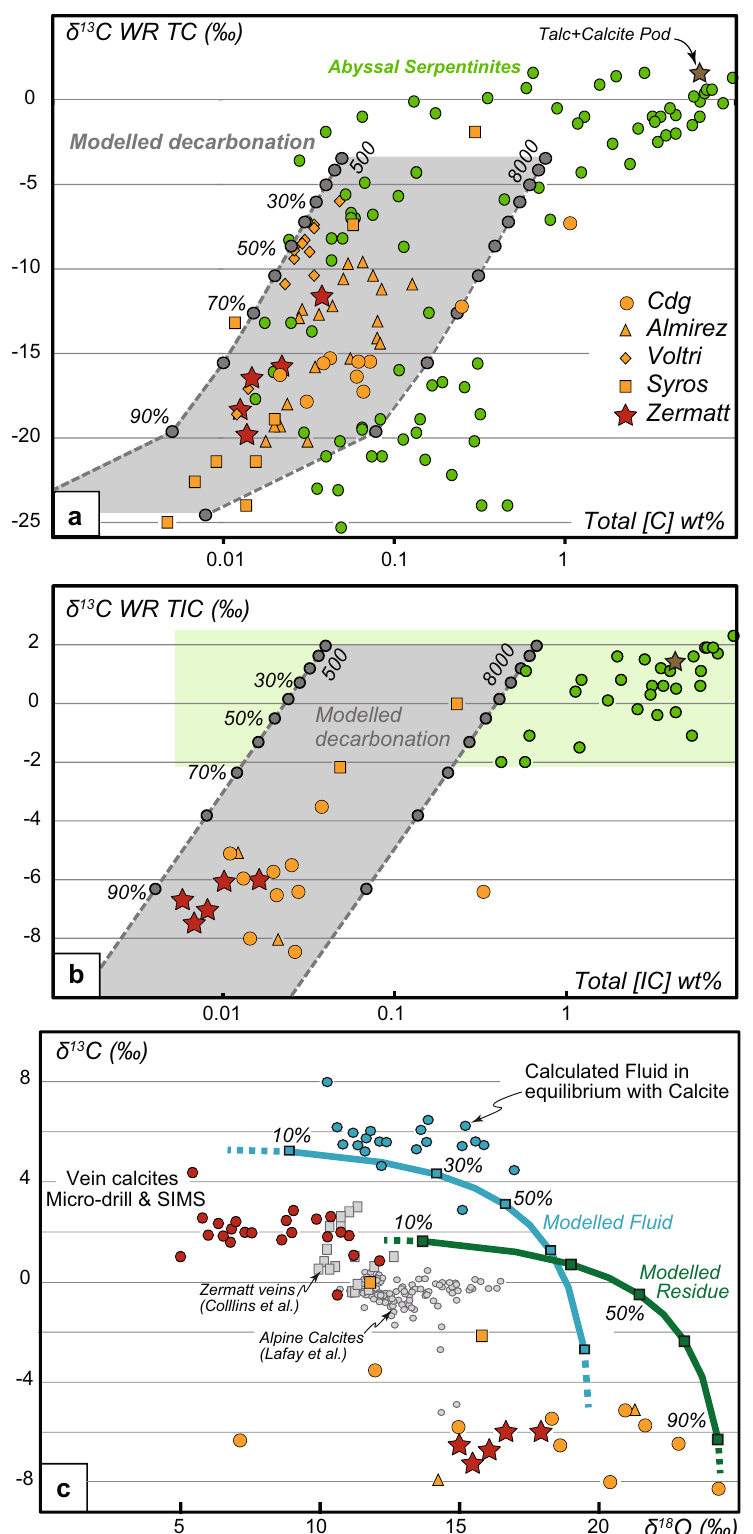
Fig. 5 Carbon bulk-rock and calcite isotopic and elemental variations. a Bulk rock total carbon isotopic composition ( δ 13 CTC) versus total carbon content for the Zermatt samples, compared to abyssal 12,57 and subduction-related serpentinites and meta-serpentinites/meta-peridotites from the Almirez (Spain), Voltri (Italy), Syros (Greece), and Cima di Gagnone (Cdg, Switz.) blueschist and eclogite massifs. b Bulk rock inorganic carbon isotopic composition ( δ 13 CTIC) versus inorganic carbon concentrations of the same sample suite. Green box = possible extent of abyssal serpentinite composition. c O and C isotopic composition ( δ 18 OTIC and δ 13 CTIC) of the calcites present in veins (red dots) and the bulk meta-serpentinites (red stars). Bulk veins from Zermatt 55 , calcite compositions of Alpine samples 50 for comparison. On top of the three fi gures, a simple Rayleigh decarbonation model at 600°C is presented with the % of devolatilization (see Method) and calculated fl uid composition in equilibrium with measured calcites (blue